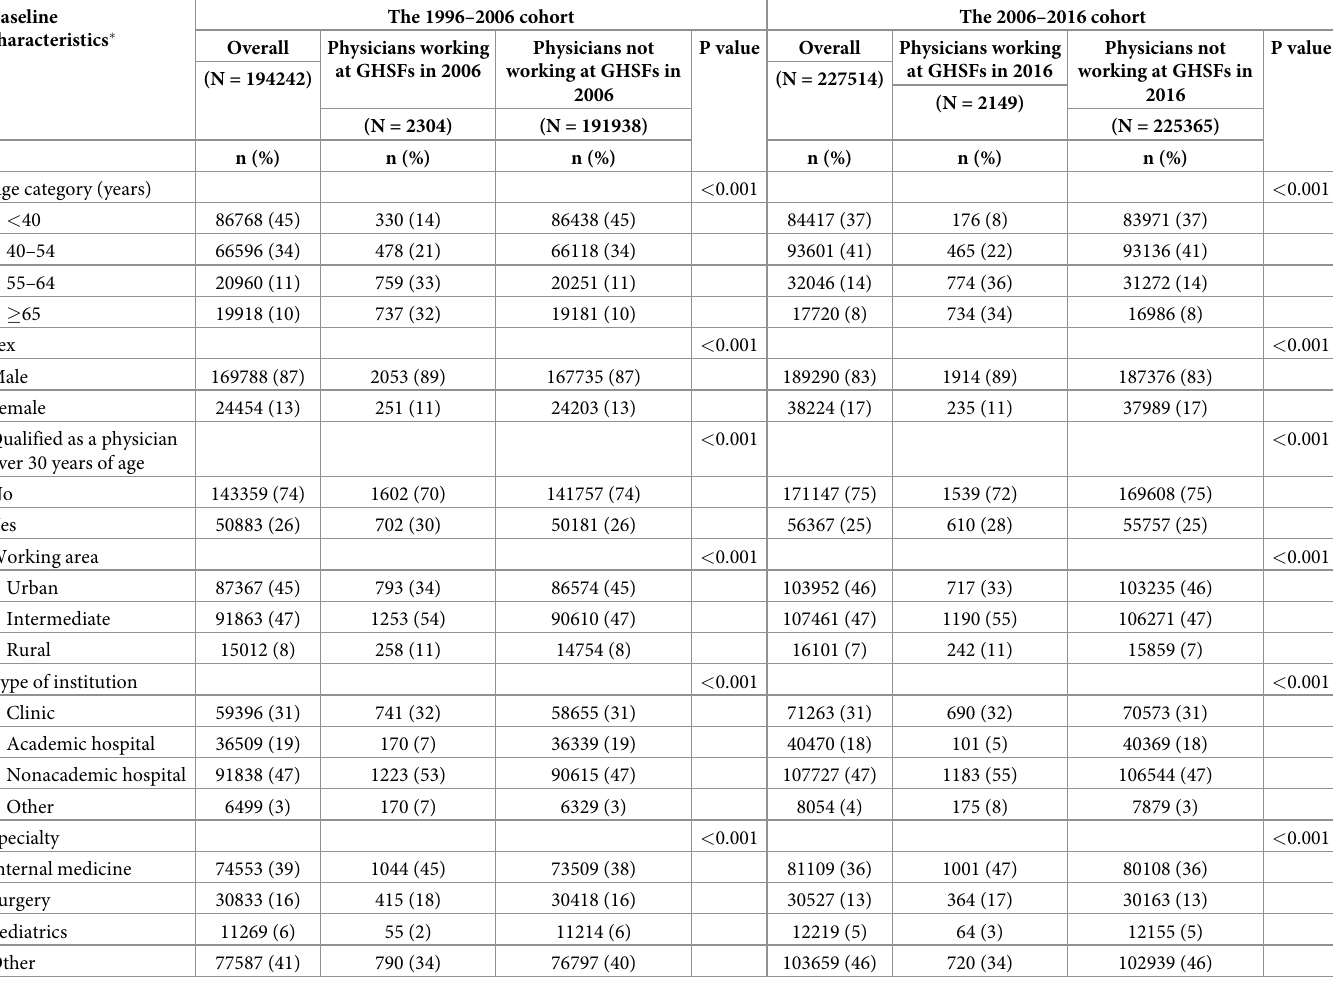
Table 2. Baseline characteristics of physicians (except for physicians already working at GHSFs) in the 1996–2006 and 2006–2016 cohorts overall and by outcome